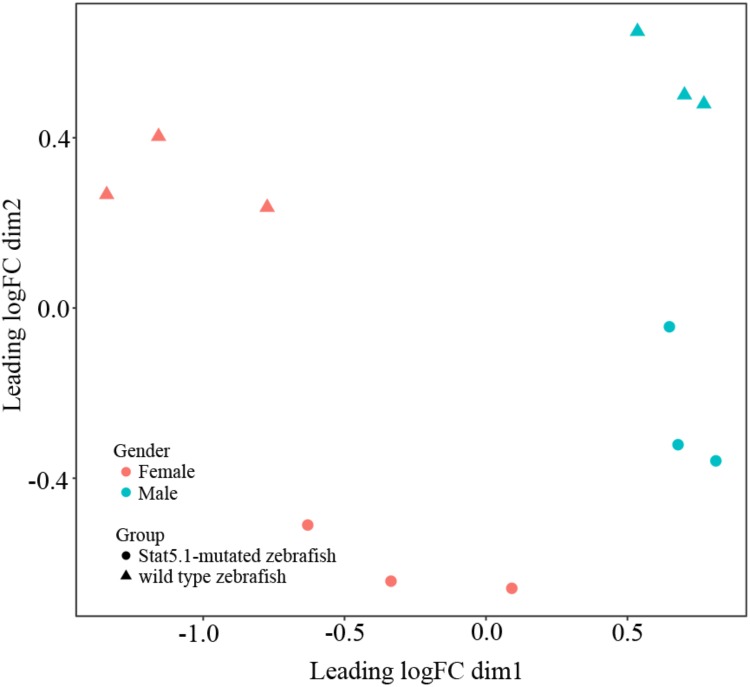
Multidimensional scaling analysis (MDS) representing the distances between wildtype and stat5b mutant samples. Dimensions (Dim) 1 and 2 represent distances between samples, which was calculated by average log2 fold change for the top 500 genes. Dim 1 showed the difference between male and female and dim 2 showed the difference between stat5b-mutated and wildtype samples. The triangle represented wildtype samples and the circle represented stat5b-mutated samples.